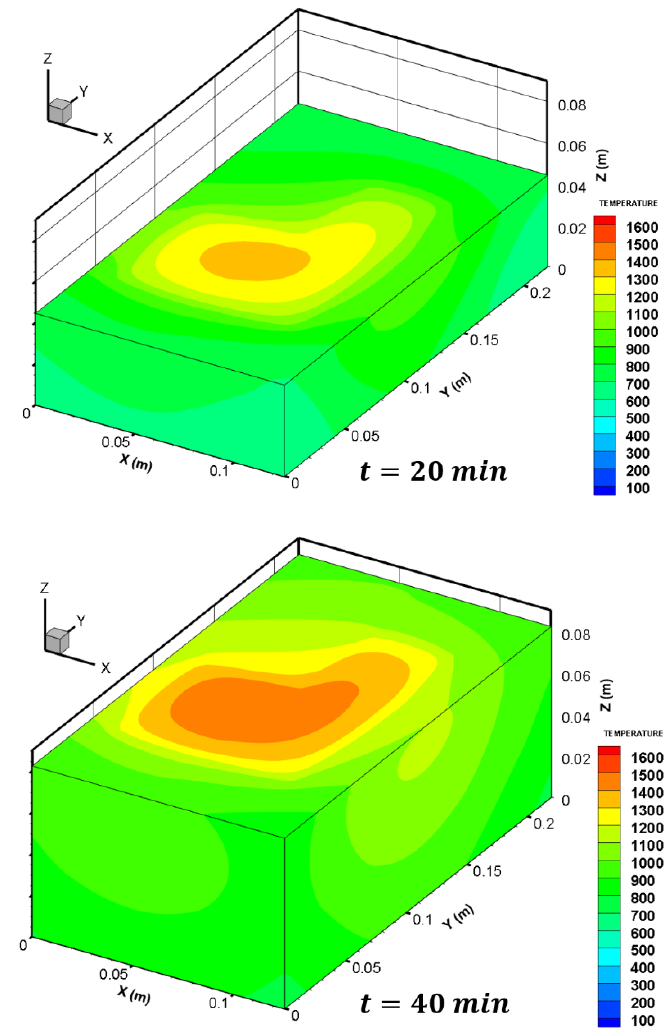
Figure 13. Three dimensional temperature field computed within the charge at t = 20 min and t = 40 min .